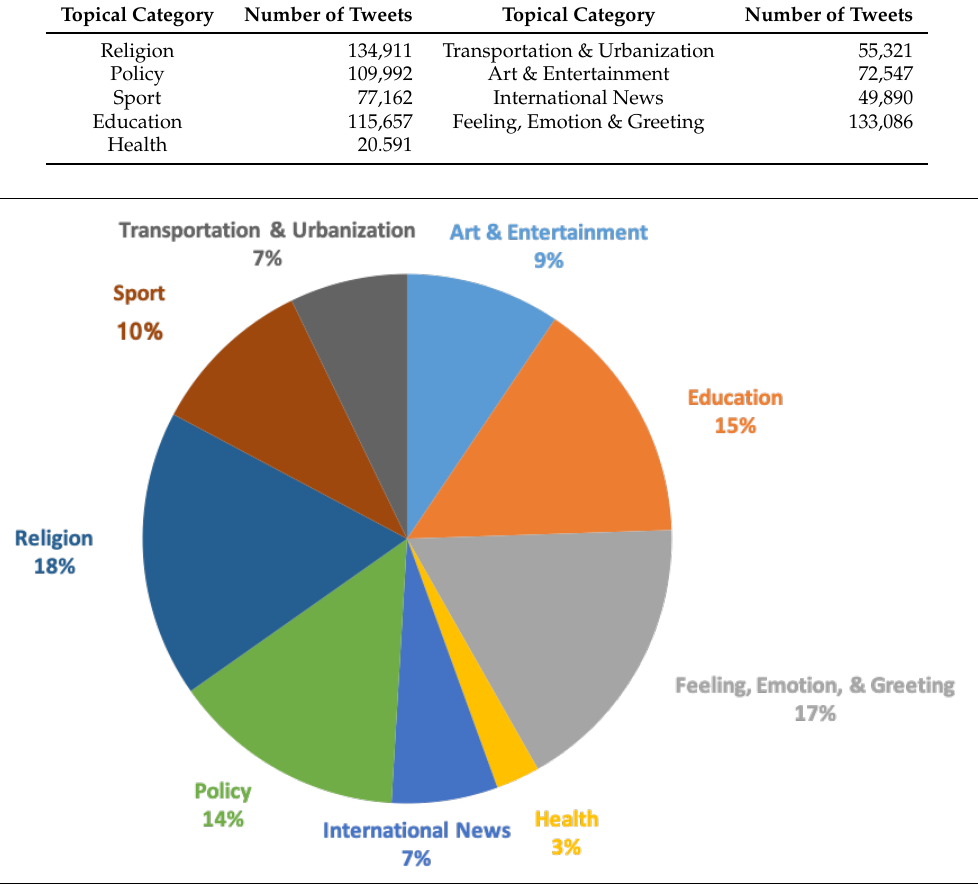
Figure 6. A pie chart showing the percentage of tweets for the nine topics of